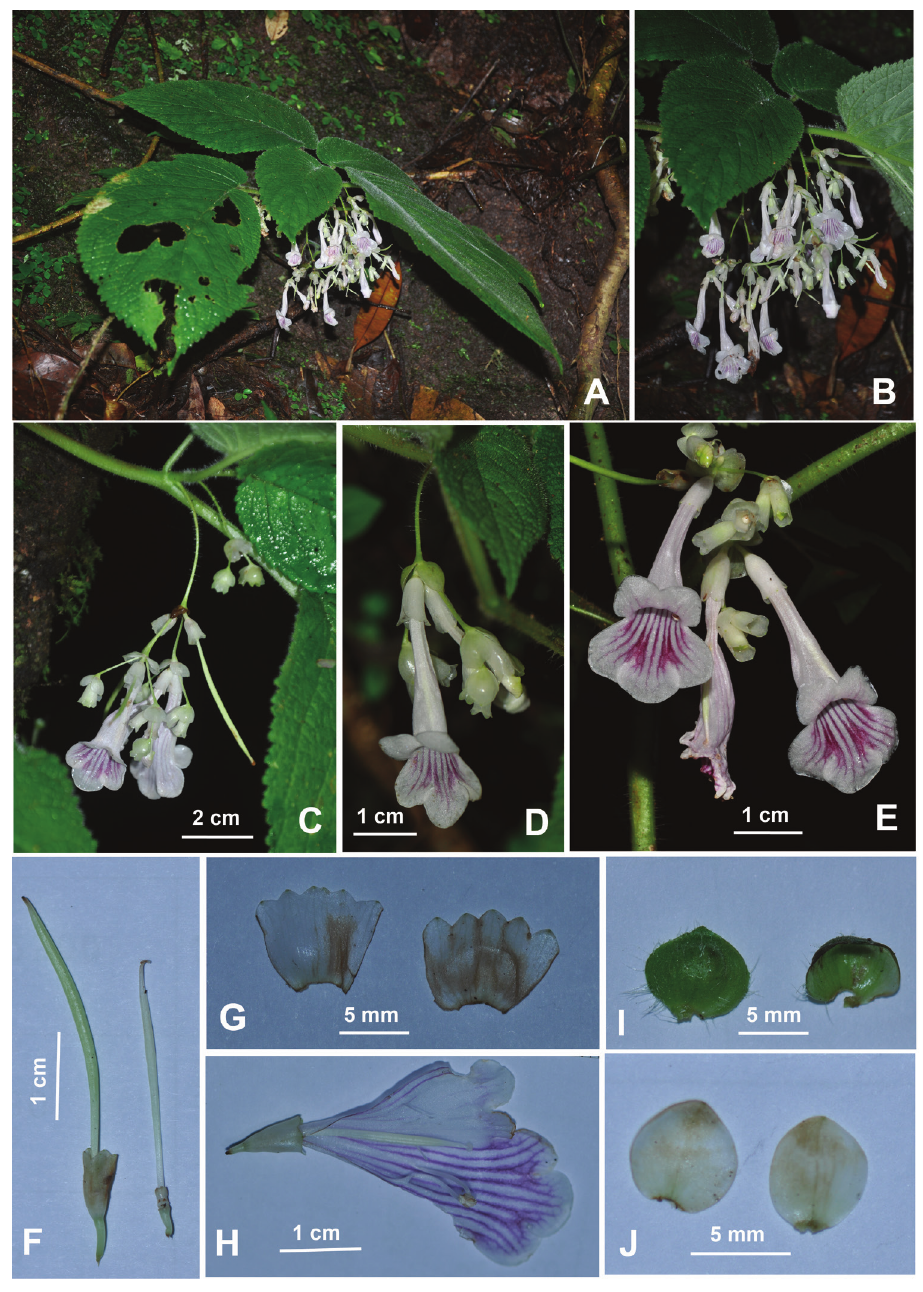
Figure 5. Didymocarpus brevipedunculatus Y.H.Tan & Bin Yang, sp. nov. A, B Habit C, D inflorescence E flowers F young capsules G dissected calyx H dissected corolla I bracts J bracteoles. Photographed by Y.H.